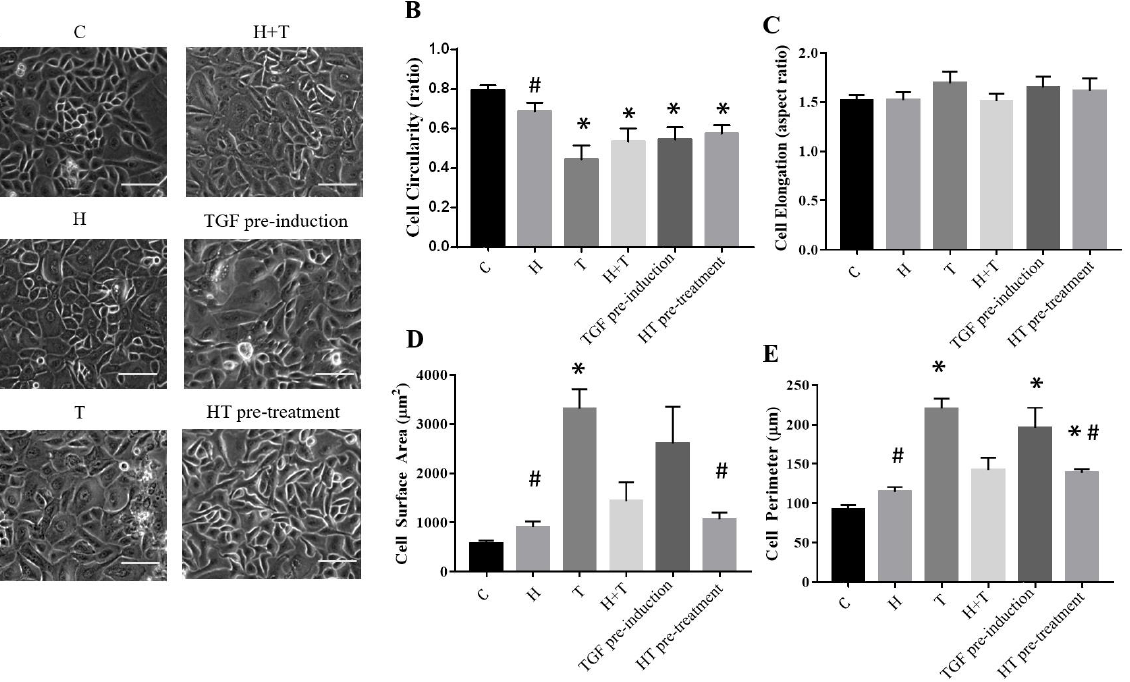
Figure 4. ( A ) REC morphology following culture in the six conditions. ( B ) Cell circularity. ( C ) Cell elongation. ( D ) Cell surface area. ( E ) Cell perimeter. * p < 0.05: significantly different from control. # p < 0.05: significantly different from Group T (Supplementary Material Table S4). Scale bar represent 100 µm.